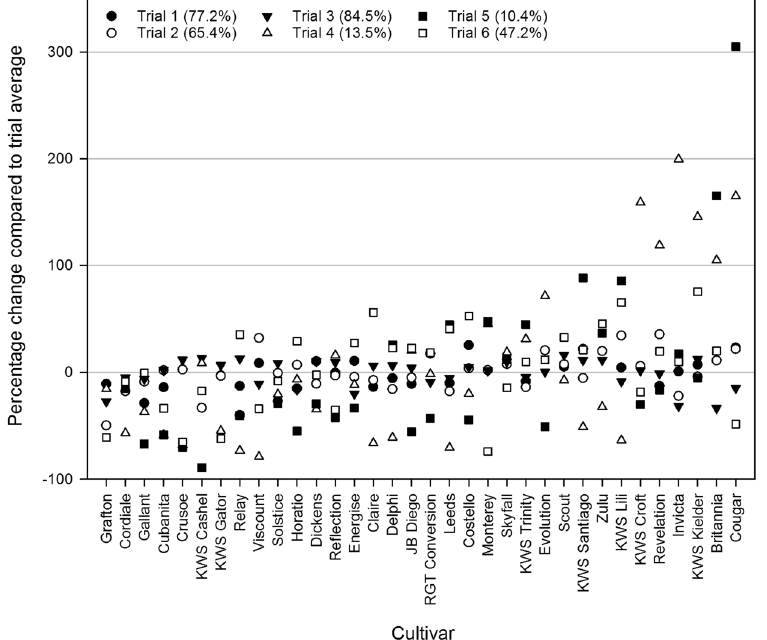
Figure 4. Relative change per cultivar in the percentage plants infected in the soil core bioassay compared to the trial site average. Legend shows the trial site and in brackets the average percentage plants infected with take-all at each